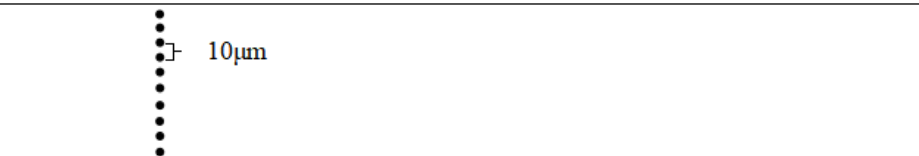
Figure 1. Schematic diagram of hardness test.